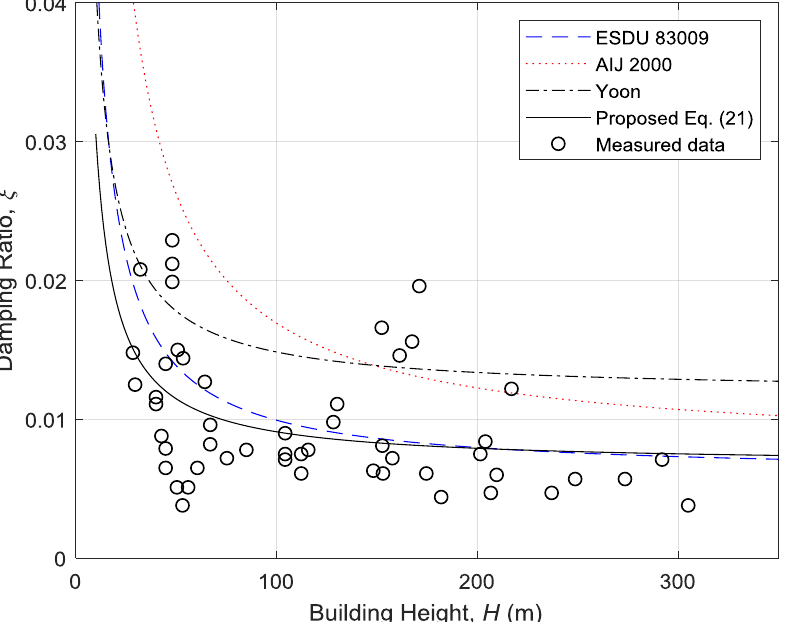
Figure 12. Comparison of proposed equation for estimating damping ratio with various empirical formulae—both frequency- and amplitude-dependent terms are included.